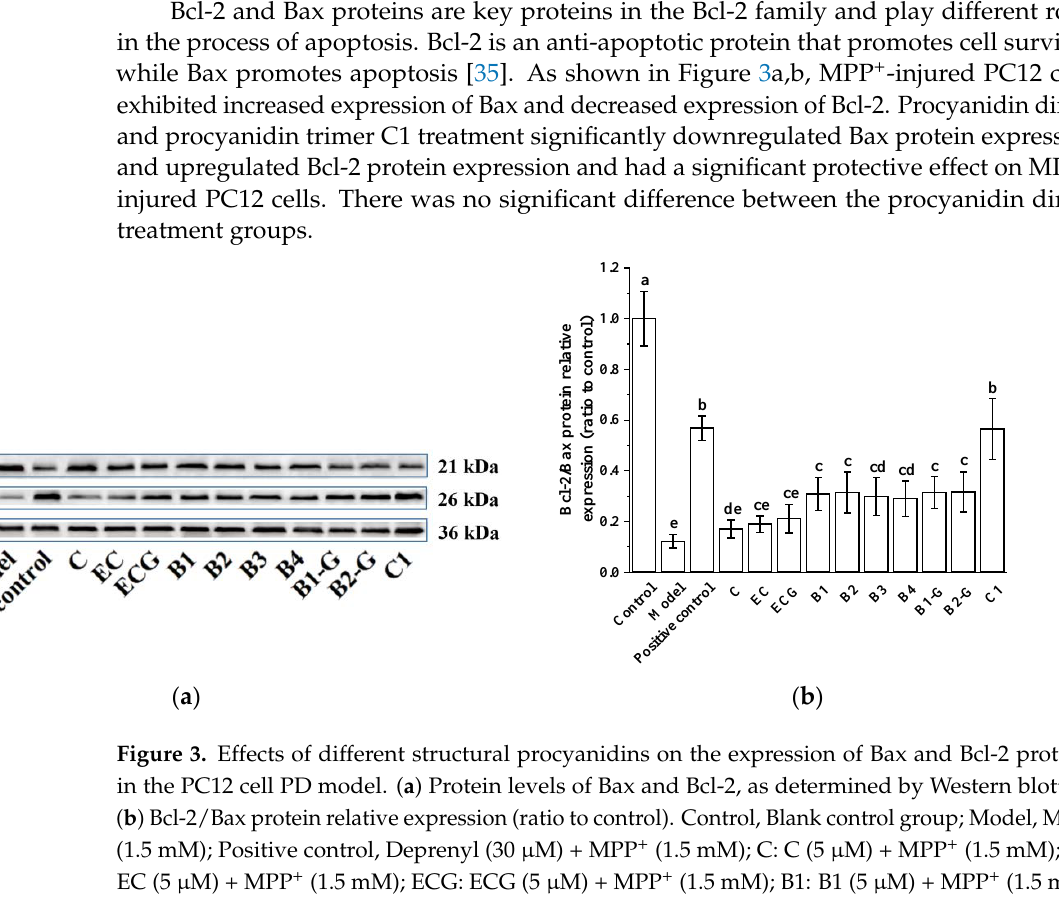
7 of 21 Figure 2. Effect of different structural procyanidins on MPP + -induced PC12 cell damage. ( a ) Effect of 2.5 µM procyanidins with different structures on the survival of MPP + -injured PC12 cells. ( b ) Effect of 5 µM procyanidins with different structures on the survival of MPP + -injured PC12 cells. ( c ) Effect of 2.5 µM procyanidins with different structures on MPP + -induced LDH release. ( d ) Effect of